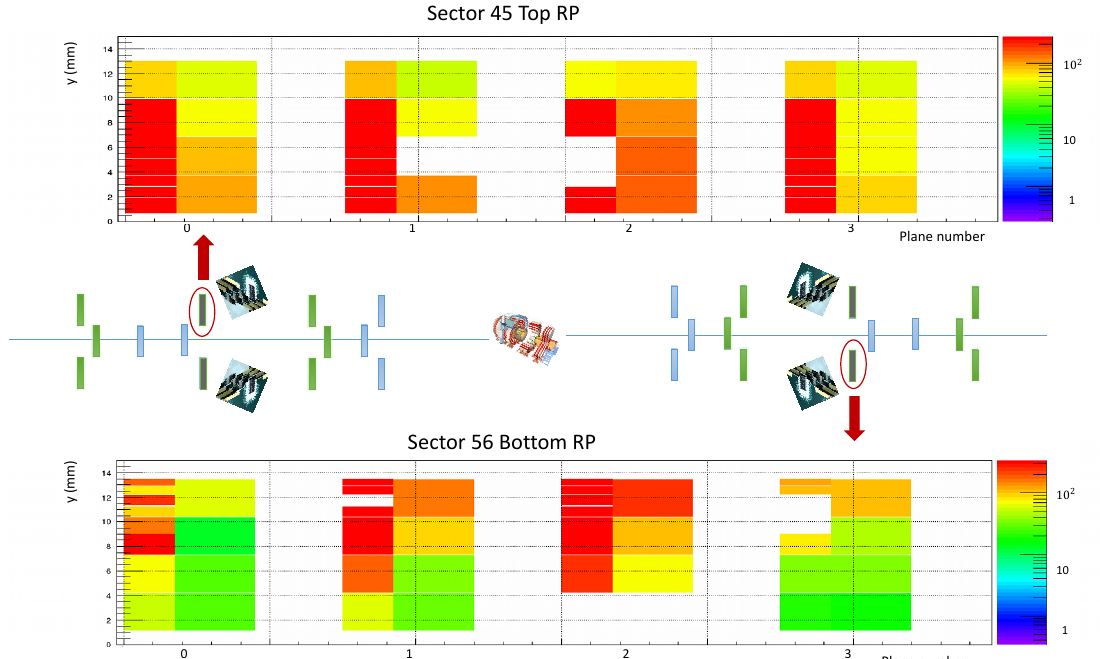
Figure 5. Occupancy of the two RPs fully equipped during the test runs.